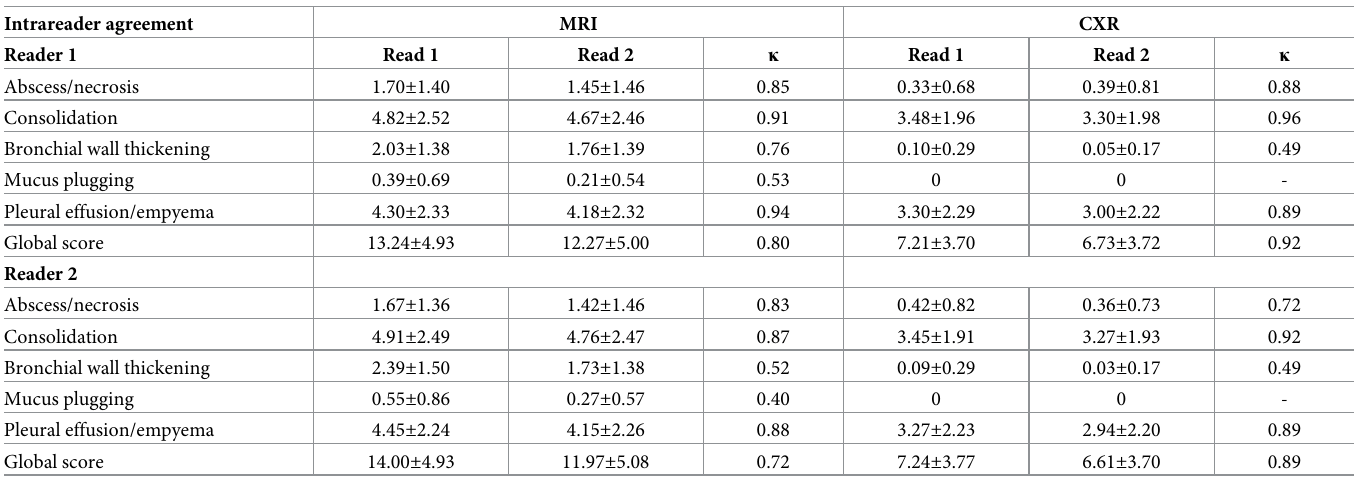
Table 2. Intra-reader agreement for MRI and CXR